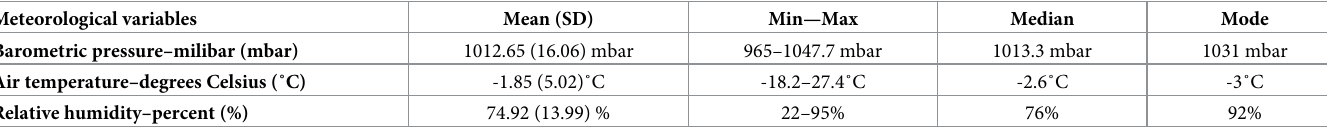
As evident by inspecting the individual slopes in Fig 1, eight patients reacted opposite to an increase in BMP compared to the majority (40 patients) who reported less pain with increased BP. To test the validity of dividing the sample in two clusters based on the pain and stress reports adjusted for BMP, unsupervised cluster analyses were performed. Both the pain inten- sity- and the pain unpleasantness data based on the LMM revealed a two-cluster structure based on the unsupervised Cluster node analysis, with a good cluster quality (Silhouette mea- sure) of .9 for both pain intensity and pain unpleasantness. Supervised cluster analyses (K- means cluster) supported a two cluster solution for both the pain intensity data (F (1, 2710) = 25286.95, p < .001) and the pain unpleasantness data (F (1, 2710) = 25844.66, p < .001). To test possible differences between the eight patients reporting an opposite pattern of pain levels compared to the majority of the sample, baseline data obtained before the measurement period were compared. Symptoms of depression and anxiety, general psychological distress, pain intensity and unpleasantness, impact of fibromyalgia on daily functioning and health related quality of life presented in Fagerlund, Hansen & Aslaksen [17] were compared between groups. The only significant difference between the sub-group of eight patients and the major- ity of the sample was the lower level of anxiety in the sub-group of eight patients (t (1, 47) = 3.17, p = .003) compared to the other 40 patients.